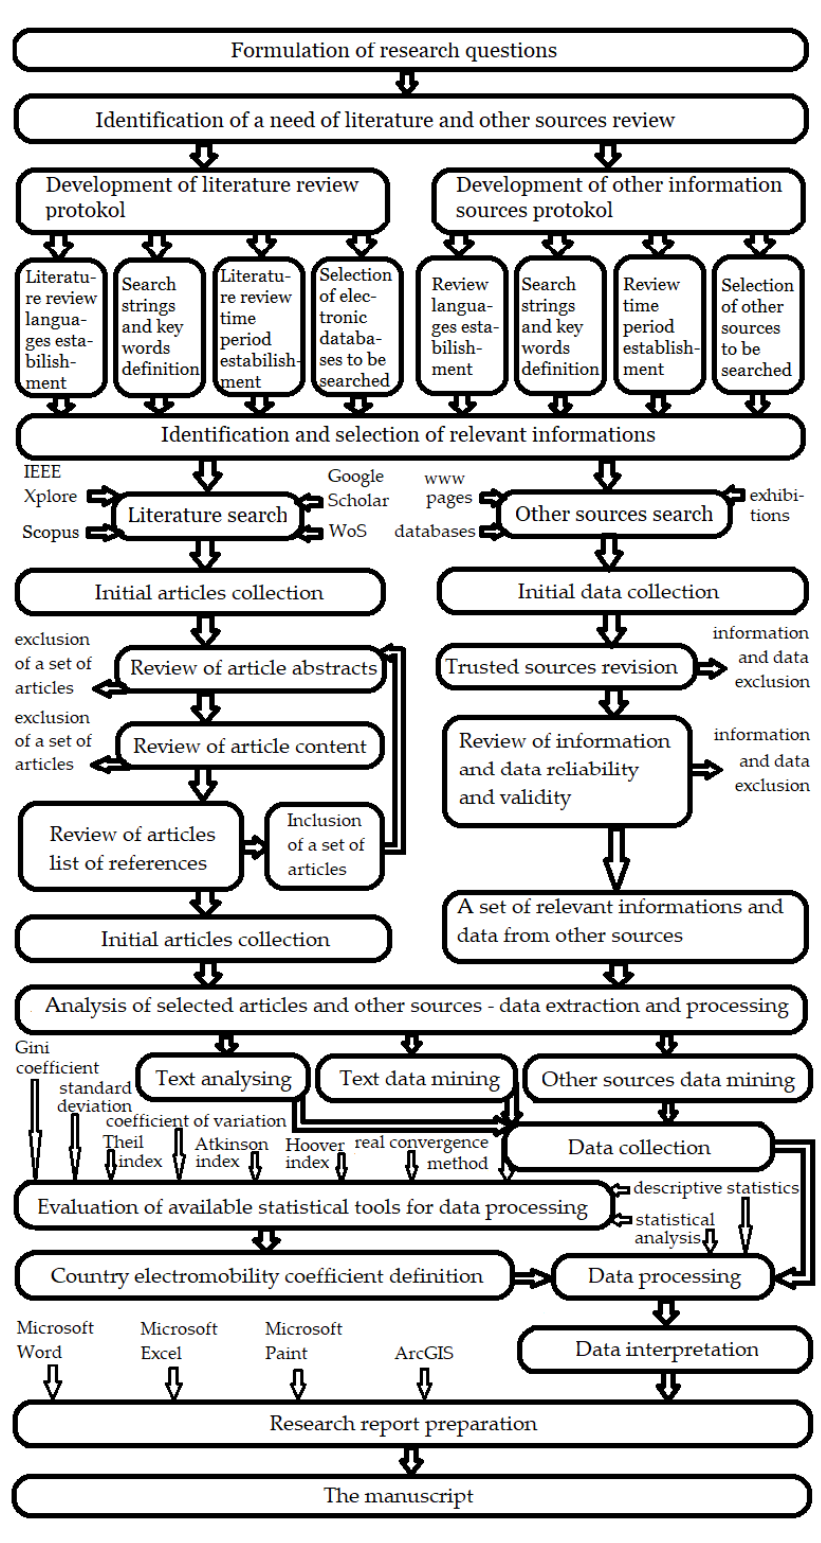
Figure 3. Structurogram of scientific approach and scientific work of the paper.